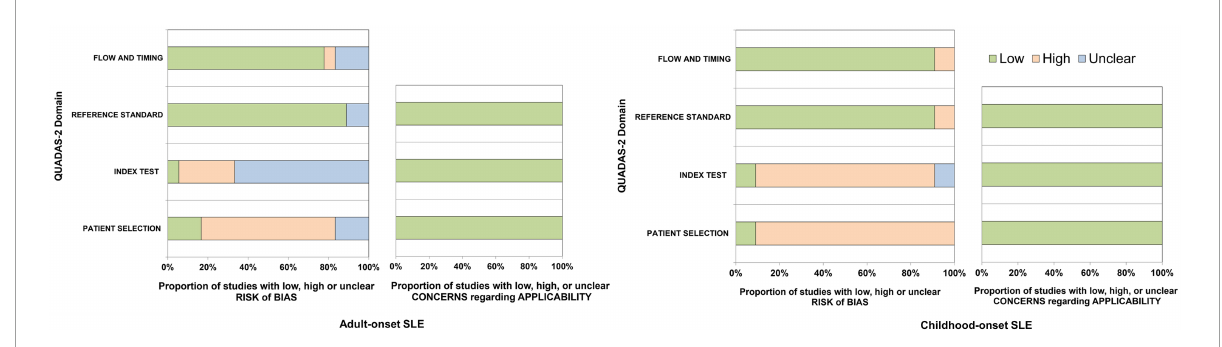
FIGURE2 The quality assessment of diagnostic accuracy studies-2 for adult-onset and childhood-onset SLE